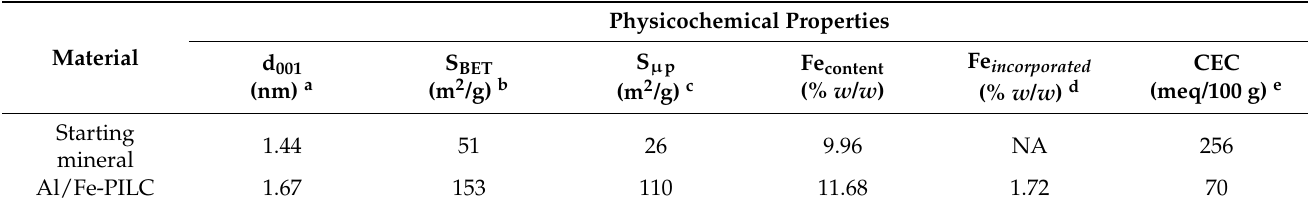
Table 1. Main structural ant textural properties of the starting mineral and the pillared Al/Fe-PILC clay catalyst. Material Starting mineral